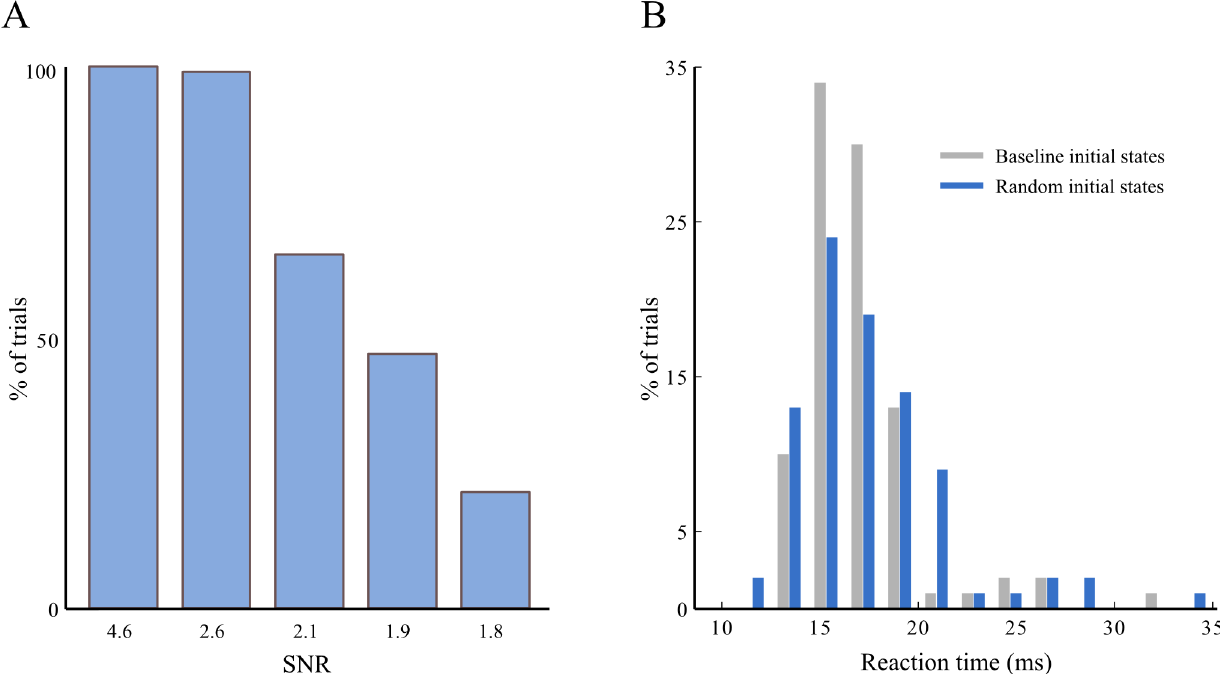
Fig 8. Performance of the model under adverse conditions. (A) Simulations to test robustness against noise in the PNs. Percentage of correct trials (i.e. trials in which the model displayed the correct KC representation) for low SNRs. For these simulations, we added white noise of different variances to all PN activity. The model is said to display the correct response if the Euclidean distance in the firing-rate-space between the inferred and expected (i.e. used to create the data) KC responses is smaller than a threshold (see main text). A decrease in performance can be observed only for SNRs smaller than 2.6. (B) Simulations to test robustness against KC states not at baseline at the onset of an odor. Histogram of reaction times (see Methods) for trials with initial KC states set to a baseline (light gray) or a random state (blue). These reaction times were calculated for two completely dissimilar sequences with high SNR. Therefore recognition is rapid. The reaction times for trials with random initial conditions are slightly more varied and the mean reaction time is 19ms, as compared to 17ms when the initial KC activity is at